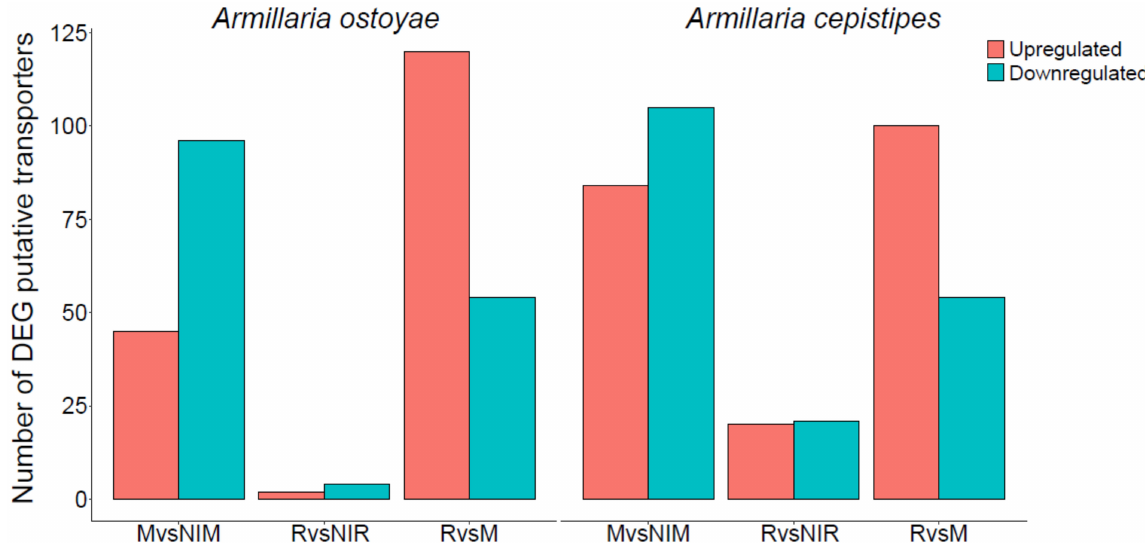
Figure 6. Number of differentially expressed putative transporters in the two species. The number of upregulated (orange) and downregulated (blue-green) genes are shown for M vs NIM, R vs NIR, and R vs M comparisons in the two